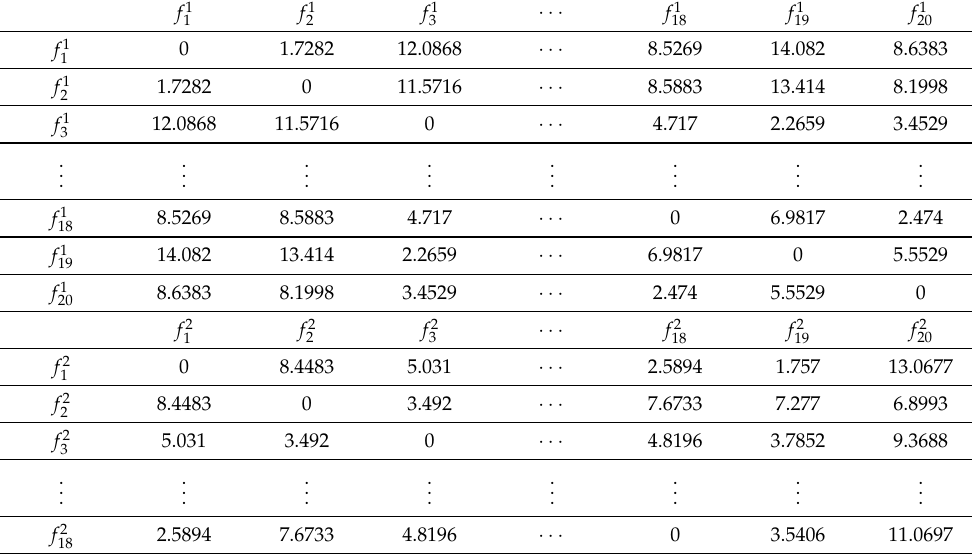
Table A1. Euclidean distance matrices for animal 1 (top block), animal 2 (middle block) and animal 3 (bottom